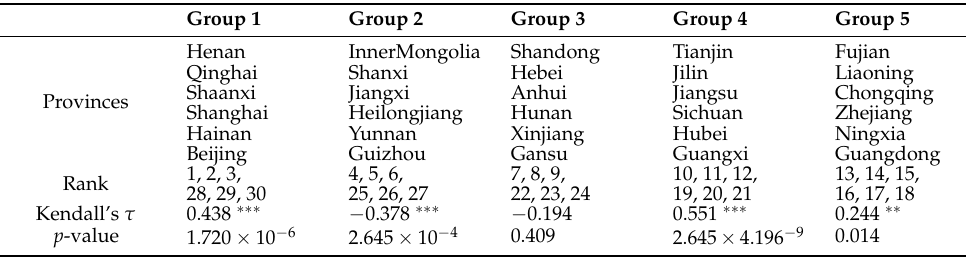
Table 15. The grouping results according to the industrial structure, and Kendall’s τ estimation between carbon inequality and carbon efficiency for the six provinces in each group. Group numbers 1–5 represent intra-group differences from the largest to the smallest. ∗∗∗ stands for statistical significance at 1% level. ∗∗ stands for statistical significance at 5% level. Group 1 Group 2 Group 3 Group 4 Group